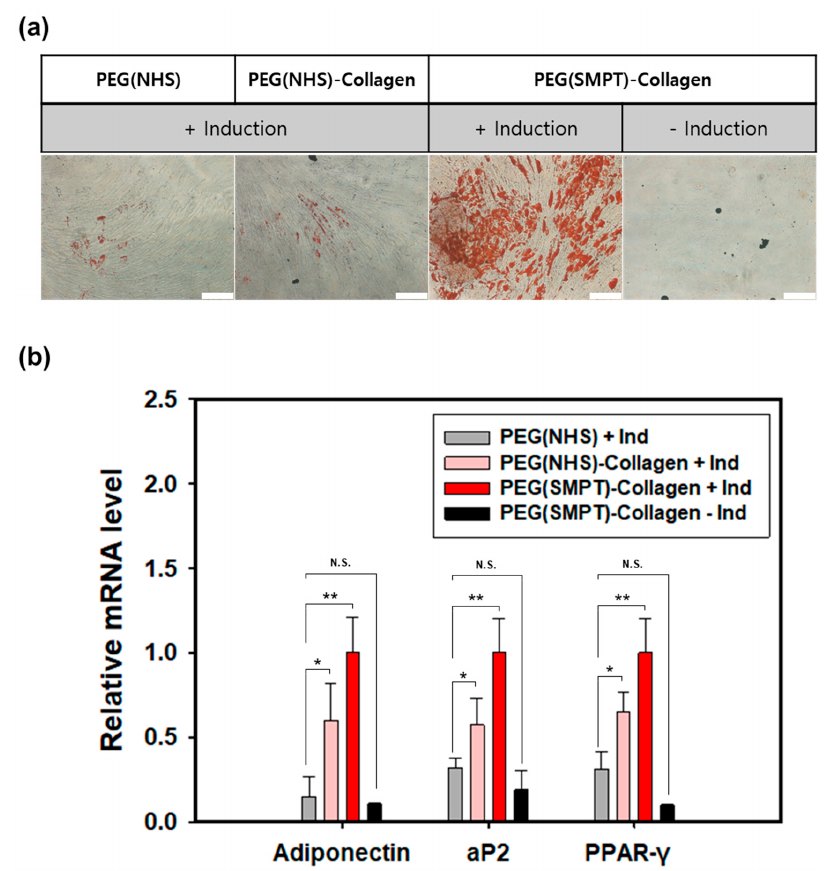
Figure 4. Adipogenic differentiation of ADSCs within each hydrogel. ( a ) Oil Red O staining of ADSCs within various hydrogels after adipogenic induction for 14 days. Scale bar: 200 µ m. ( b ) The relative mRNA expression level of adipogenic markers (adiponectin, aP2, PPAR- γ ) in 14 days of culture with induction (+Ind) media analyzed by RT-PCR. Gene expressions were normalized to that of β -actin and expression levels of the PEG (SMPT)-Collagen (+Ind) group. * p < 0.05, and ** p < 0.01 compared with PEG (NHS) with the induction media (+Ind), and N.S. refers to